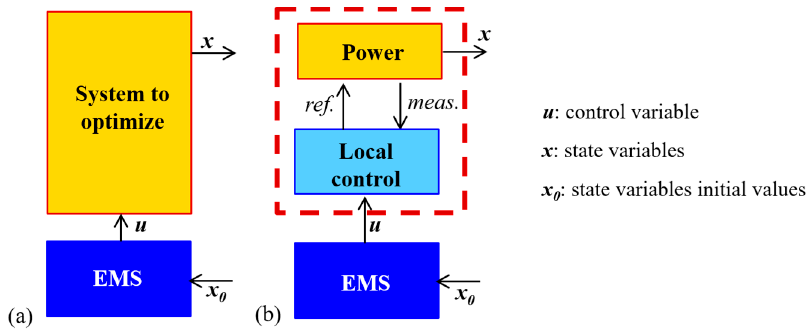
Figure 6. Optimal control scheme: ( a ) single-level control, ( b ) multi-level control.